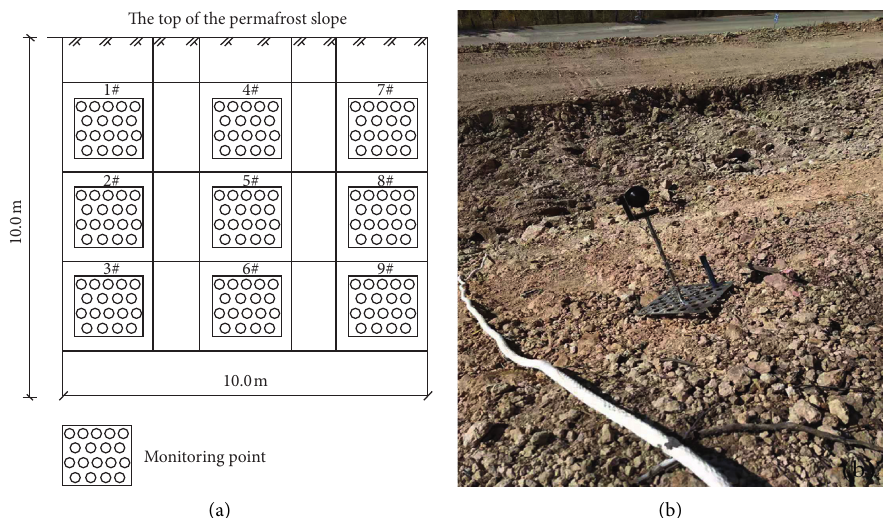
Figure 10: Schematic diagrams of the monitoring points on the slope. (a) The position of each monitoring point on the slope; and (b) the real view of the monitoring